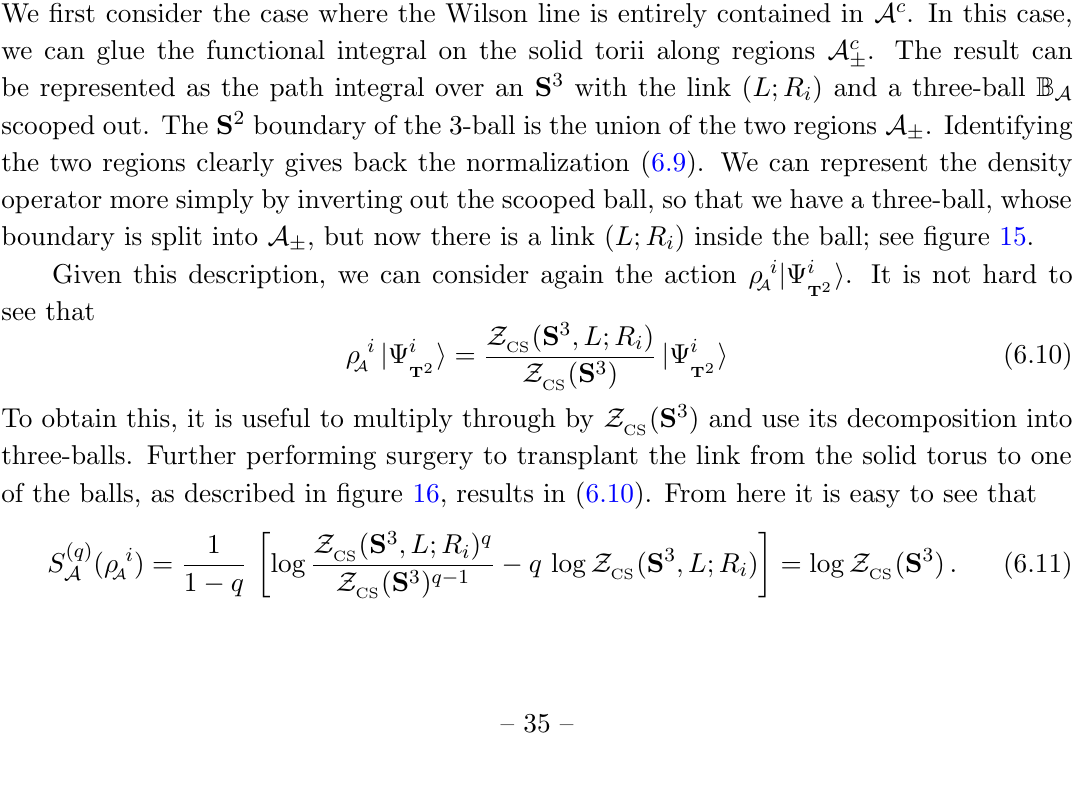
Figure 15 . The construction of the density matrix (cid:26) A that avoid interfering with the Wilson line inside the solid